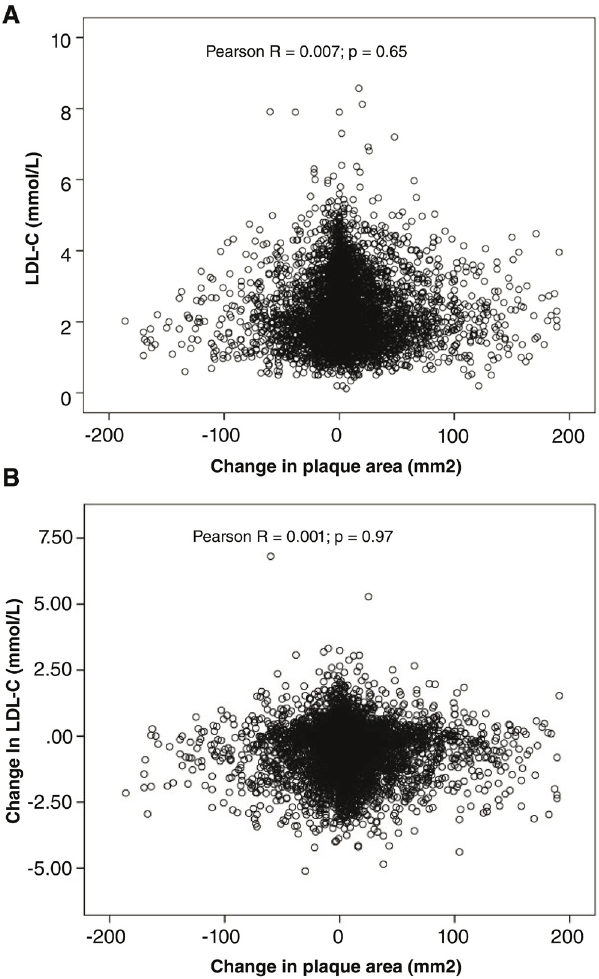
Figure 5. Correlation of low-density lipoprotein cholesterol (LDL-C) (mmol/L), change in LDL-C, and change in total plaque area (mm 2 ). Among 4,512 patients followed in a stroke prevention clinic, there was no correlation between achieved LDL-C with lipid-lowering therapy and change in carotid burden over 1 year (panel A ). Similarly, there was no correlation between change in LDL-C from baseline to follow-up and change in plaque burden (panel B